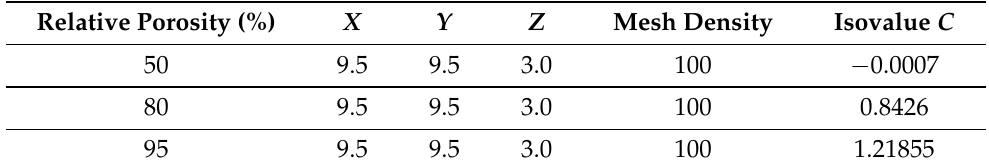
Table 1. The parameters used to construct models of varying porosities using the Minimal Surface Lattice Generator. X , Y , and Z are the number of lattice cells in each dimension. The mesh density refers to the number of points per cell. The isovalue C controls the porosity of the model.